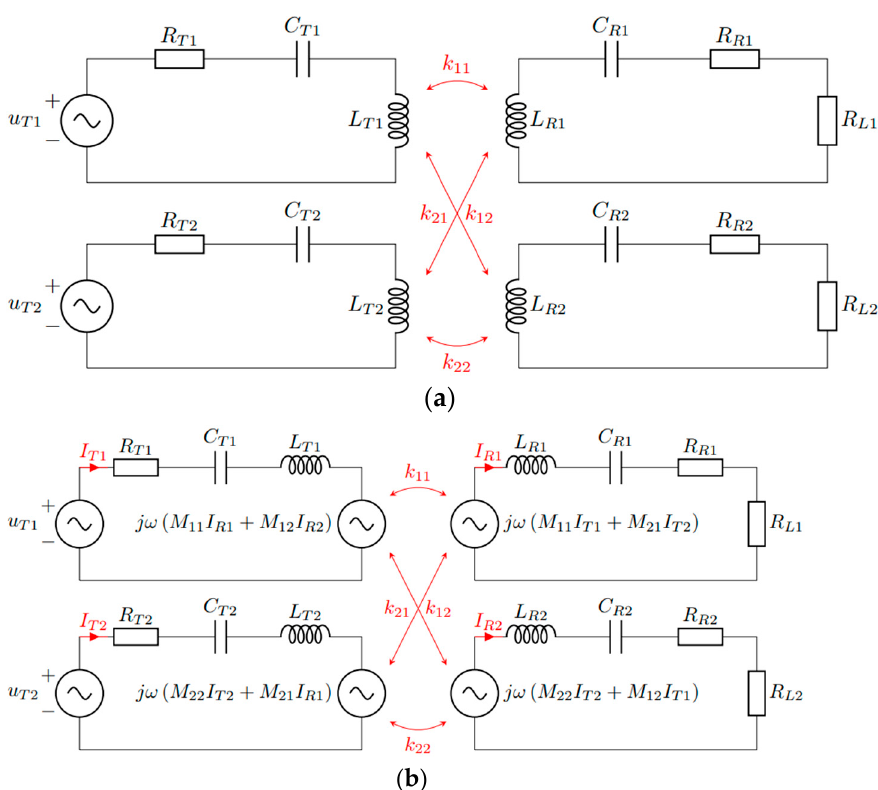
Figure 4. Simplified circuit of the IPT system using double DD coils: ( a ) simple circuit, ( b ) representation using induced voltage.